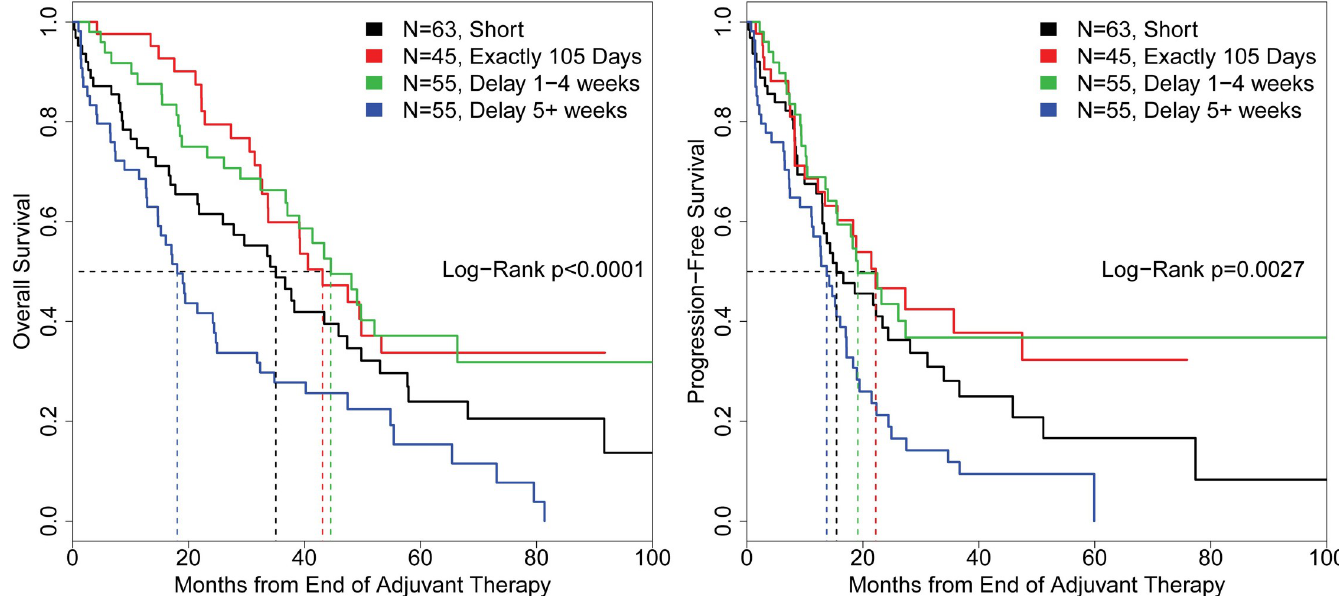
Fig 2. Stage-stratified Kaplan-Meier estimates of OS and PFS demonstrate long delays in chemotherapy (decreased chemotherapy intensity) and shortened chemotherapy regimens (incomplete regimens) are associated with poor outcomes.